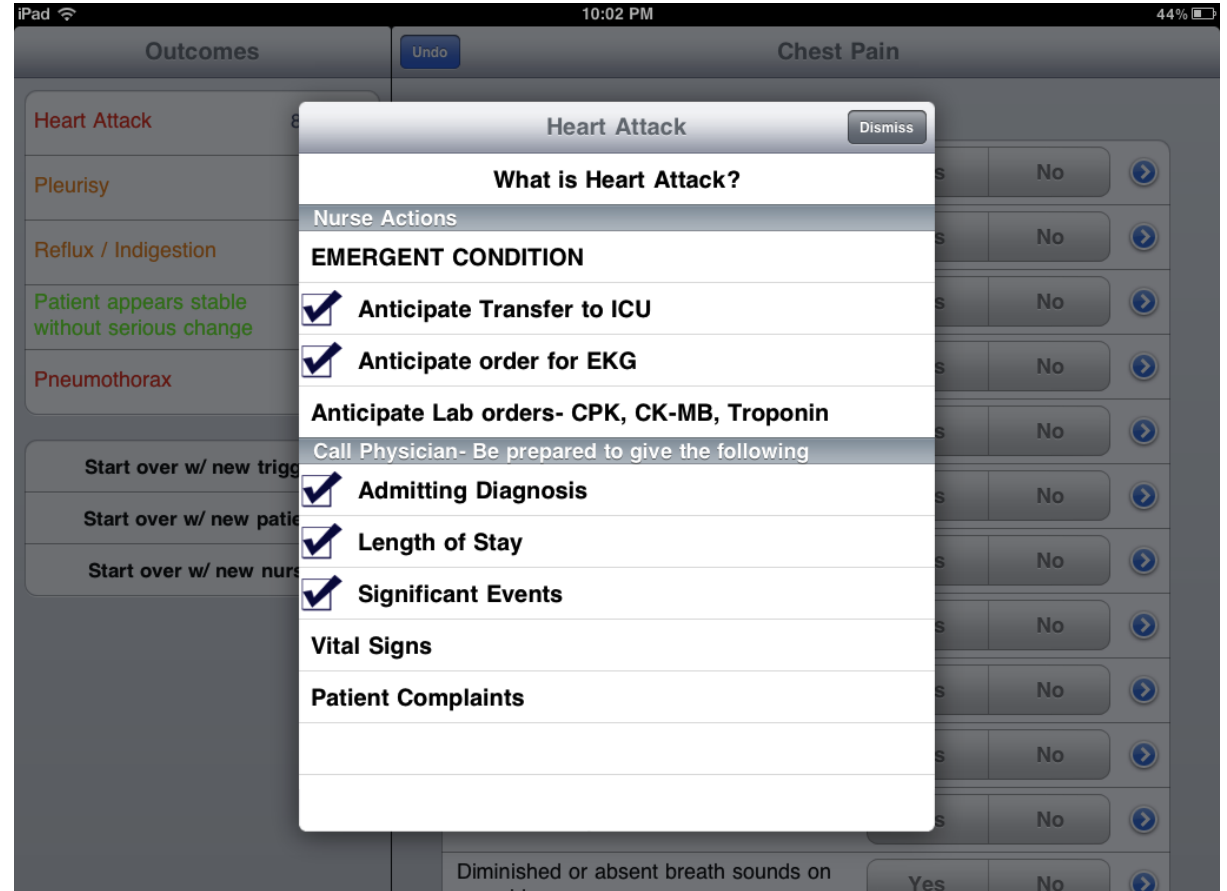
Figure 2. The action items for the nurse after a likely outcome is